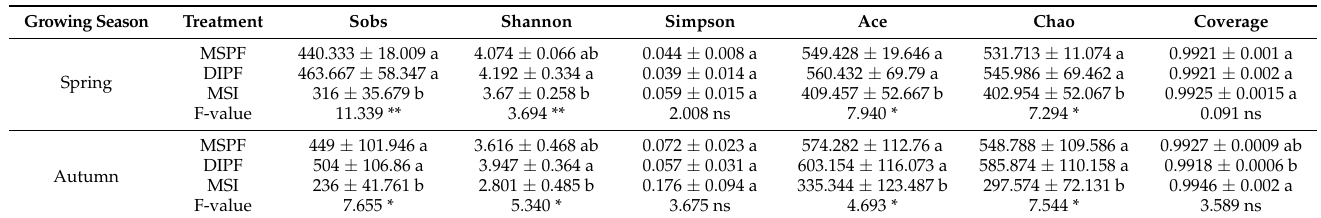
Figure 6. N 2 O emission rate in response to irrigation strategy and plastic film mulching. Table 2. Diversity indices of the denitrifying bacterial community under different irrigation strategies and PF